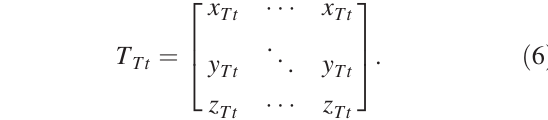
FIG. 11. Length gauge distribution.